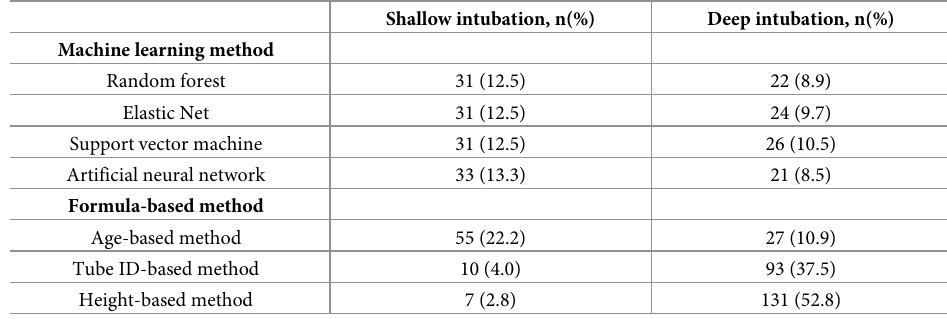
Table 3. The number of cases predicted with deep or shallow